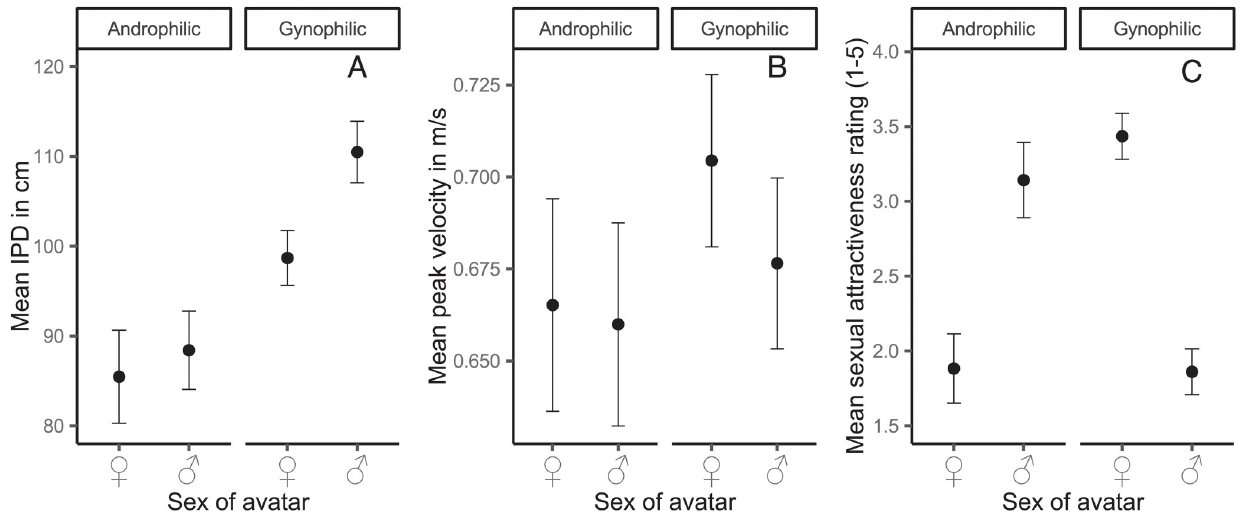
Fig 5. Mean IPD (panel A), peak velocity (panel B), and sexual attractiveness ratings (panel C) as a function of sexual orientation and avatar sex. Error bars denote ± 1 standard error of the mean.